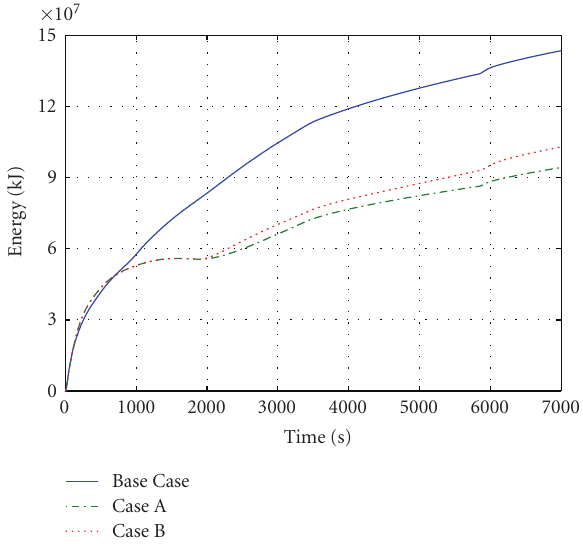
Figure 8: Energy absorption by